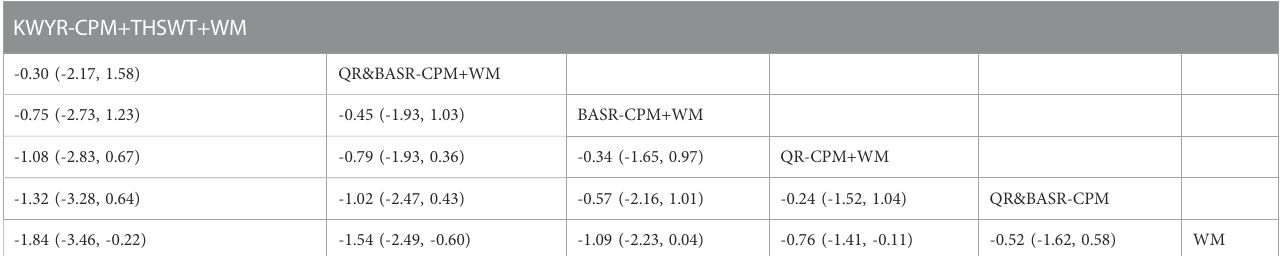
TABLE 6 Results of network meta-analysis for LVEDD.